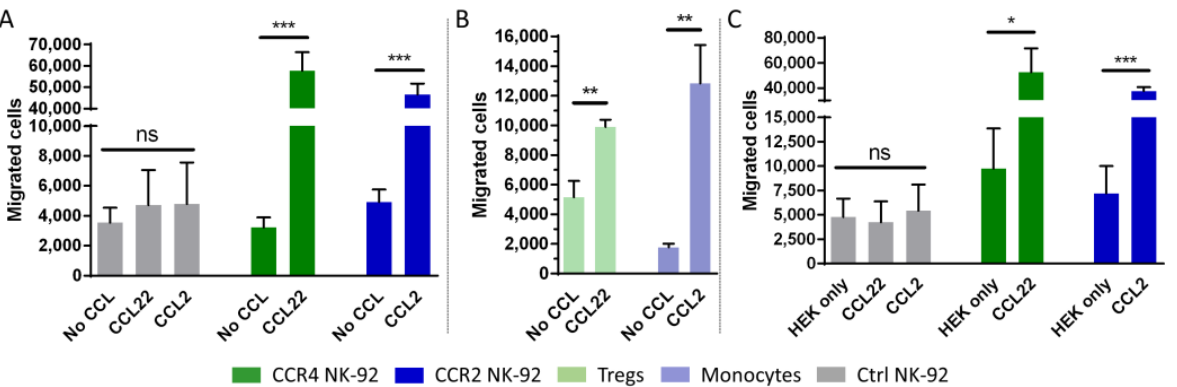
Figure 2. CCR4- and CCR2B-transduced NK-92 cells migrate towards CCL22 and CCL2. ( A , B ) NK-92 cells, T regs or monocytes were added to the cell culture insert and assessed for their potential to migrate to the lower chamber containing 50 ng/mL CCL22 or CCL2. The absolute number of migrated cells was counted by flow cytometry. Mean values with SD of n = 3 independent experiments with three technical replicates each are shown for NK-92 cells. Mean values with SD of one representative experiment out of n = 3 independent experiments with three technical replicates each are shown for T regs and monocytes. Ctrl NK-92: Untransduced NK-92 cells. No CCL: No chemokine added to the medium. ( C ) NK-92 cells with or without CCR4 and CCR2B were added to the cell culture inserts and assessed for their potential to migrate to the lower chamber in which untransduced (HEK only) or modified HEK293T cells stably expressing CCL22 or CCL2 (CCL22/CCL2) had been seeded the day before. Mean values with SD of n = 3 independent experiments with two technical replicates each are shown. The absolute number of migrated cells was determined by flow cytometry. *: p ≤ 0.05. **: p ≤ 0.01. ***: p ≤ 0.001. ns = not significant.